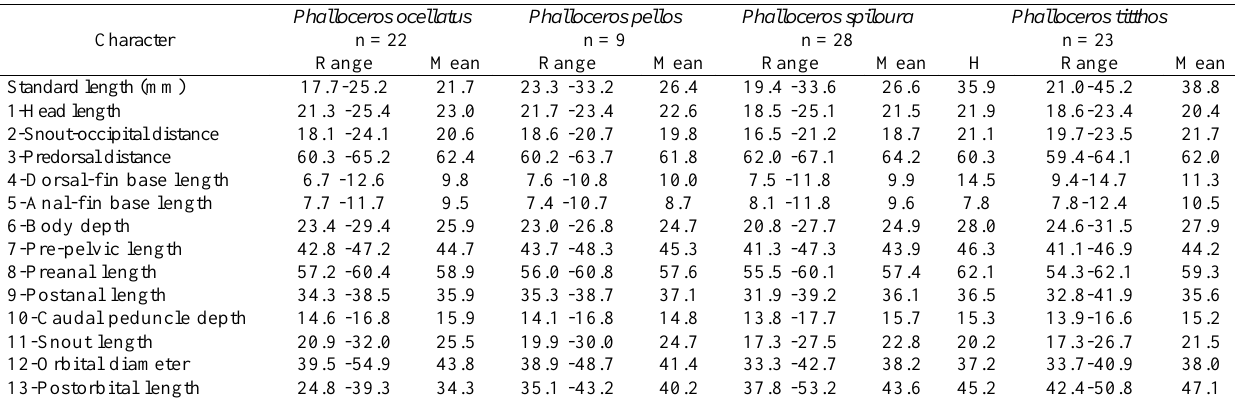
straight, located along midventral line and between anus and base of first anal-fin ray. Gonopodial appendix hook present (Fig. 24). Color in alcohol . Eye black with greenish brown pupil. Ground color pale brown, darker in upper half. Border of scales and subjacent skin replete with brown chromatophores, more con- centrated at short distance from scale border, conferring re- Table 11. Descriptive morphometrics of female specimens of Phalloceros ocellatus , P . pellos , P . spiloura , and P . titthos . Measurements 1-10 are percents of standard length and measurements 11-13 are percents of head length. H = holotype.